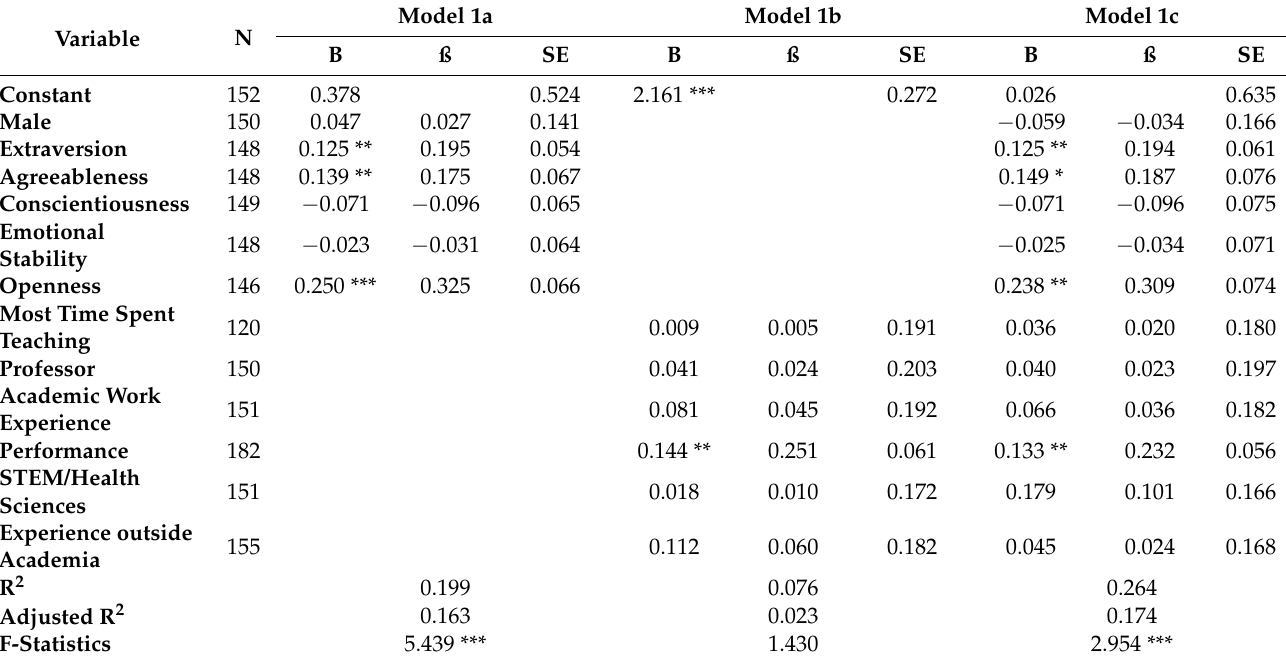
Table A1. Multiple regression models for predicting engagement in community